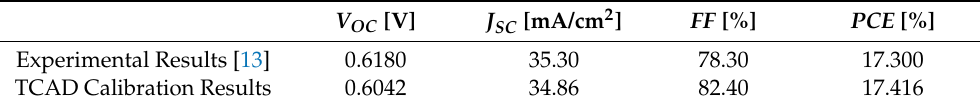
Figure 1. Simulated and experimental curves of the illuminated J-V characteristics. Table 1. TCAD results for the calibrated cell in comparison with experimental data.